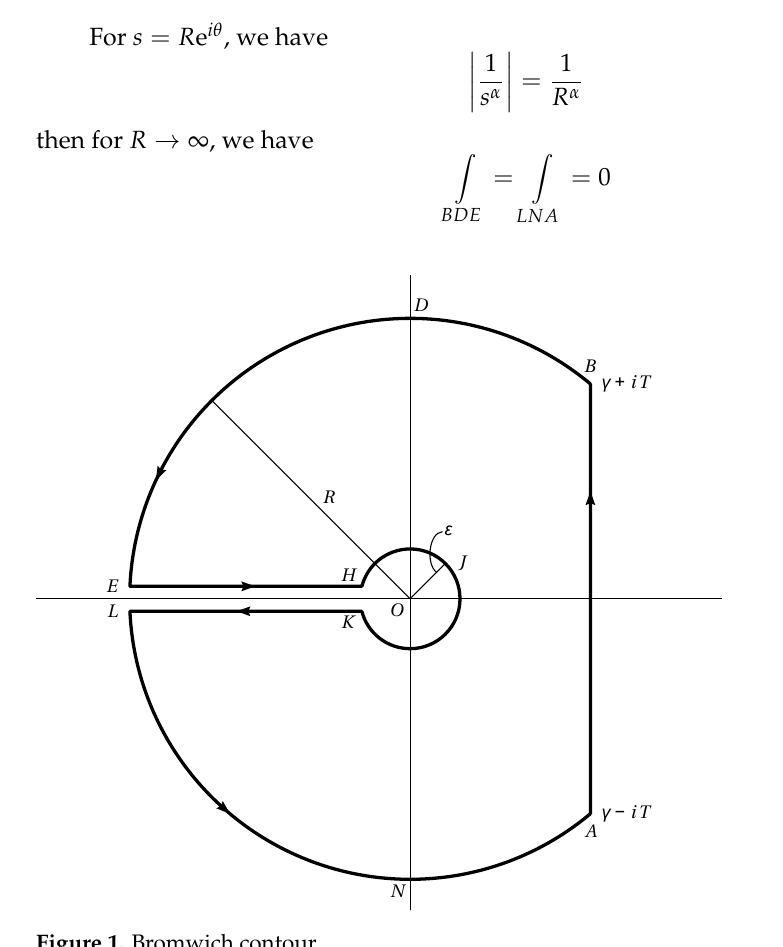
Figure 1. Bromwich